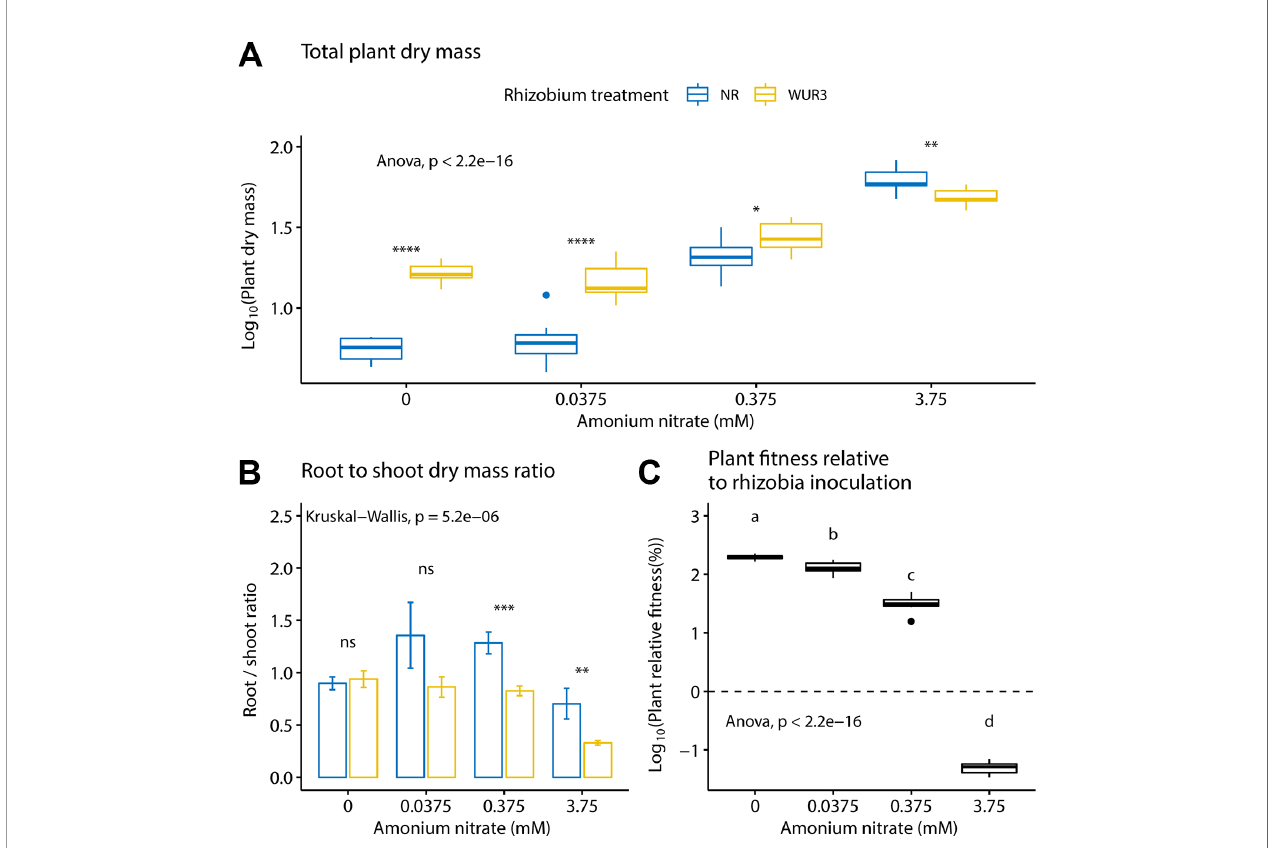
FIGURE 1 | Inoculated and non-inoculated Parasponia andersonii plant mass under four nitrogen levels. (A) Mean total (shoot + root) plant dry weight. Asterisks show pair-wise comparison signi fi cance for each nitrogen level [ANOVA, Tukey honest signi fi cant difference (HSD) test]. (B) Mean root to shoot dry weight ratio. Asterisks show pair-wise comparison signi fi cance for each nitrogen level (Wilcoxon rank sum test) NR = non-rhizobial (blue), WUR3 = Rhizobial strain B. elkanii WUR3 (yellow). (C) Mean relative host growth response to rhizobia inoculation as the difference of the total dry weight of inoculated and non-inoculated control, divided by the total dry weight of non-inoculated control. Letters represent groups signi fi cantly different from each other (ANOVA, Tukey HSD test). Error bars show standard